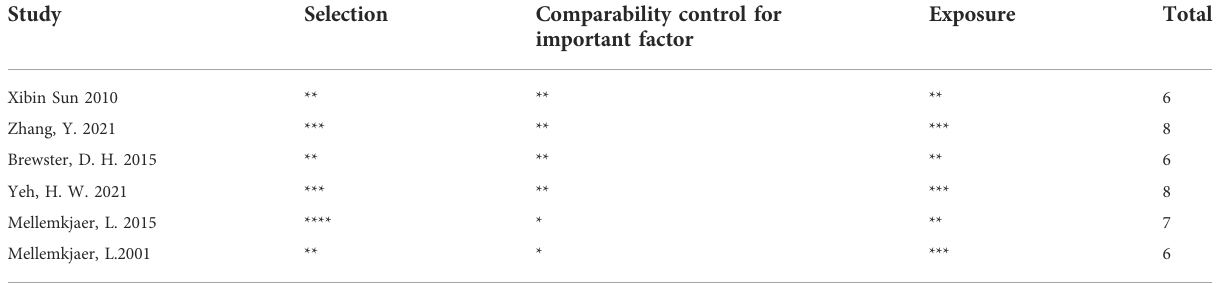
TABLE 2 Quality assessment of the studies included in the meta-analysis. Study